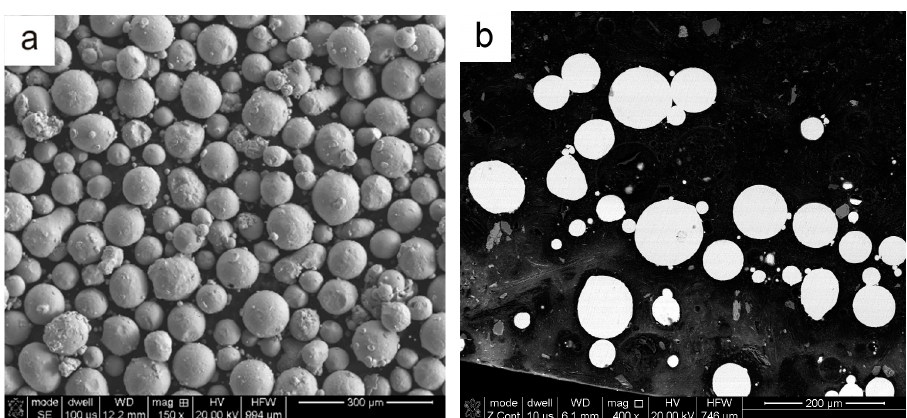
Figure 3. The morphology ( a ) and microstructure ( b ) of the Ti6Al4V powder used for manufacturing of honeycomb structures by the laser engineered net shaping (LENS TM ) technique.